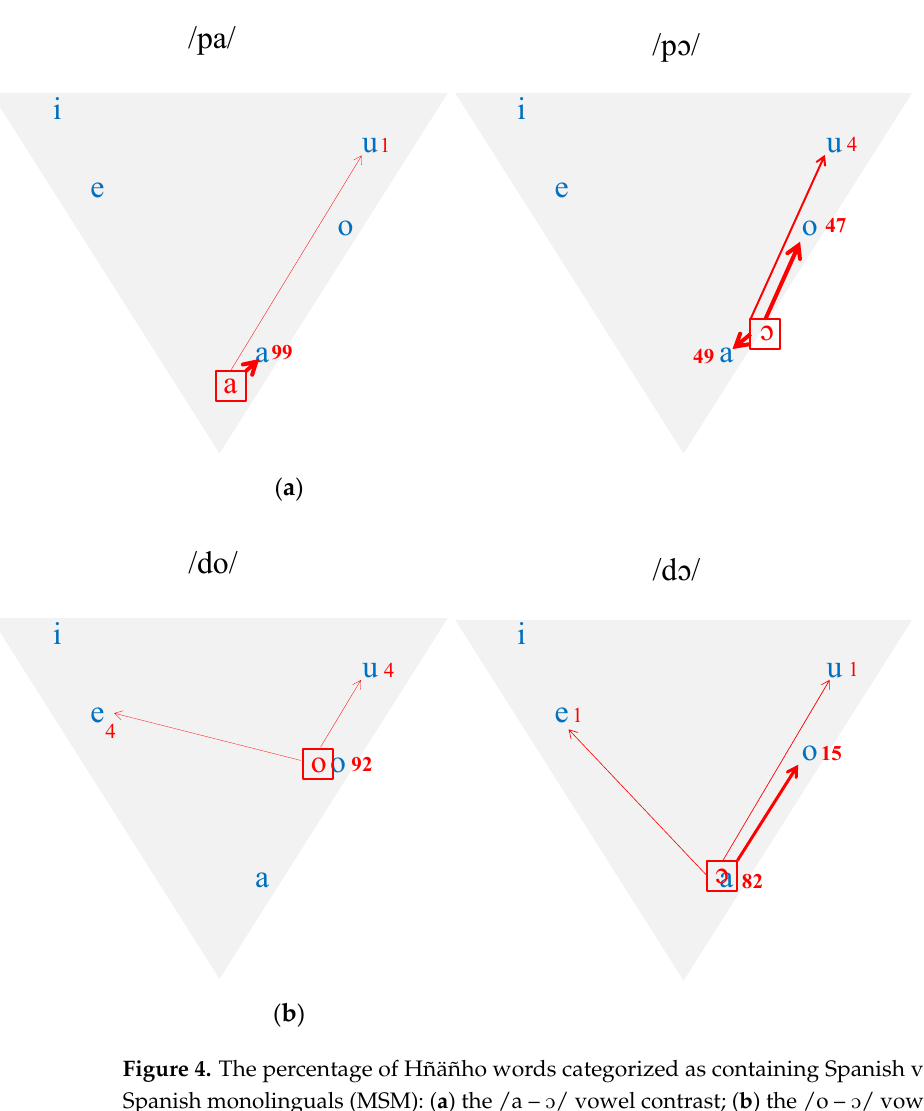
MSM either as the Spanish vowel/ a /(49%) or the Spanish vowel/ o /(47%). These findings